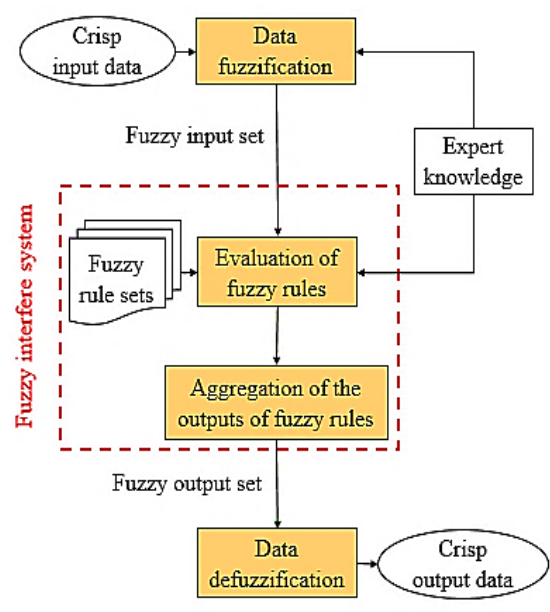
Figure 2. Flowchart of a fuzzy logic